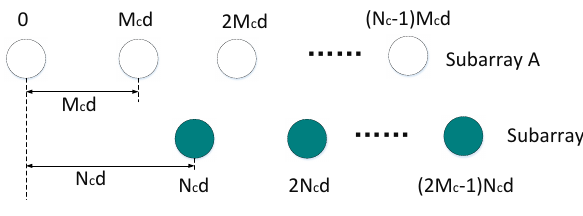
Figure 1. Elements’ positions of the